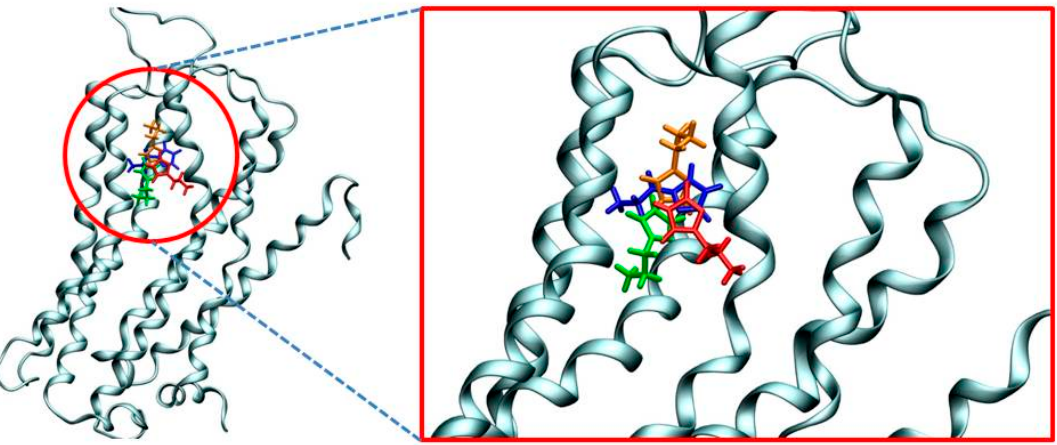
Figure 2. Overlap of four most favorable histamine binding poses within the H 2 receptor as predicted by molecular docking that differ only in the ligand orientation. The computed binding free energies are − 7.4 kcal mol − 1 (blue), − 7.1 kcal mol − 1 (green), − 6.8 kcal mol − 1 (orange) and − 6.7 kcal mol − 1 (red).